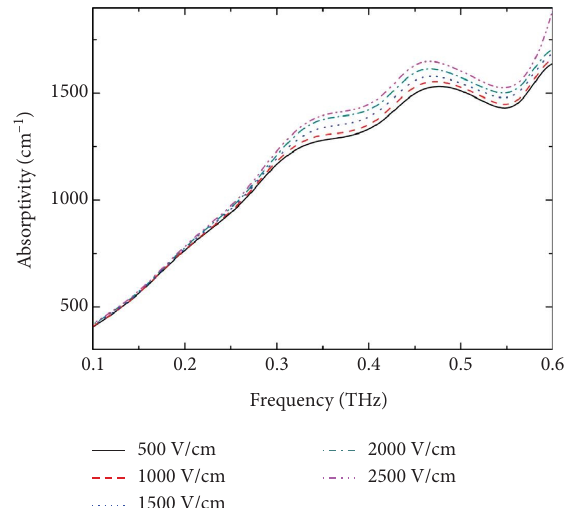
Figure 9: THz absorption spectra of MWCNTaqueous dispersion under diferent EF